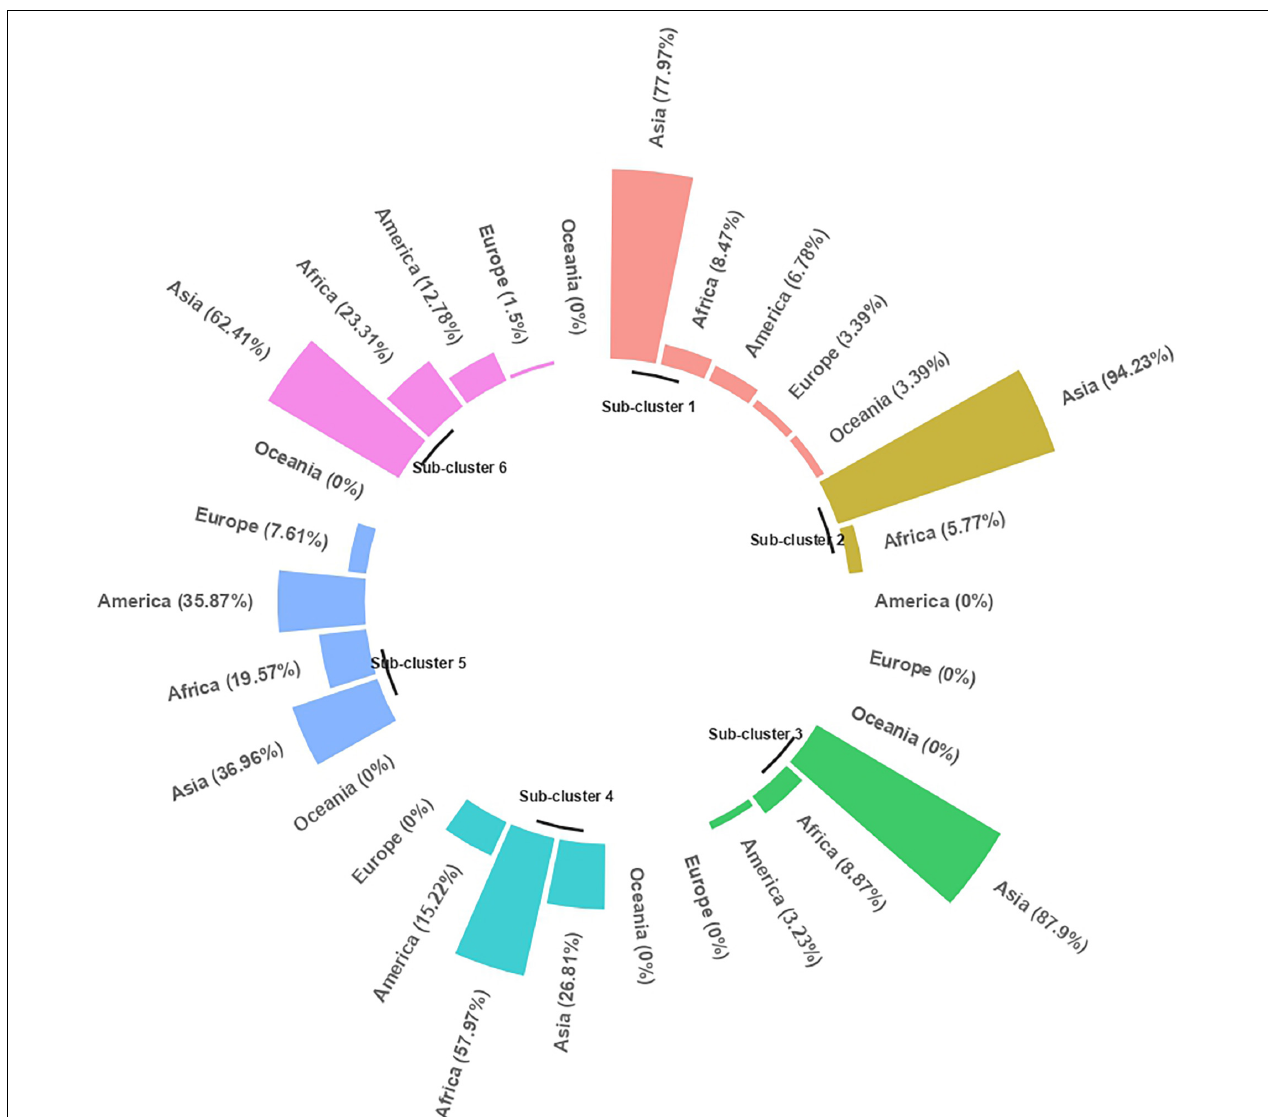
FIGURE 7 | Sub-clusters with percent geographical